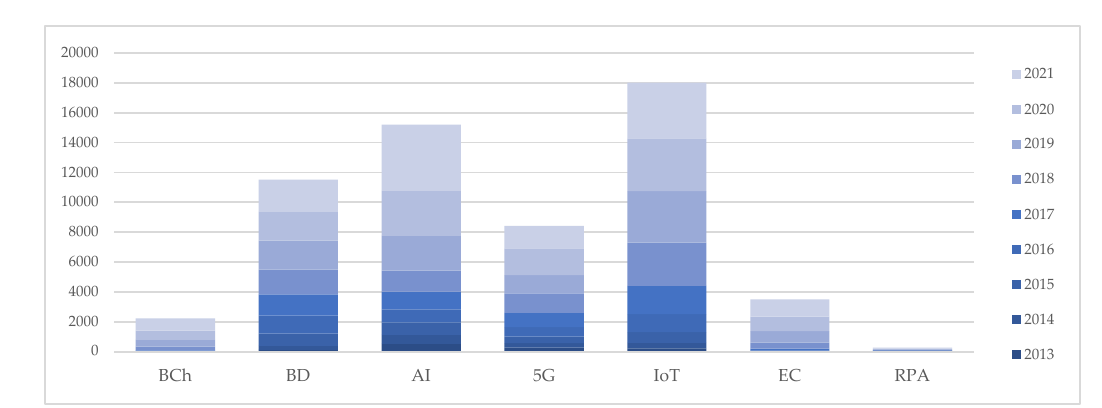
Figure 3. The publication analysis on emerging technologies from 2013 to 2021.